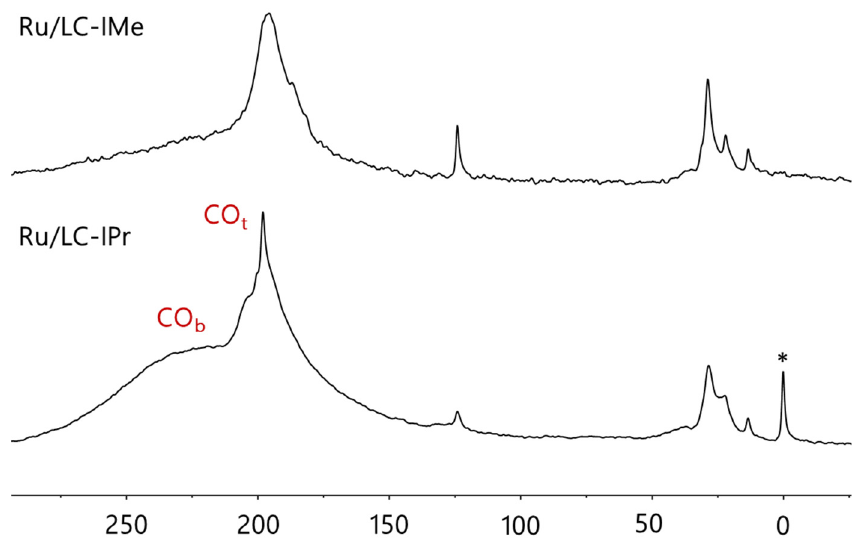
Figure 9. 13 C-MAS NMR spectra of Ru / LC-IMe ( top ) and Ru / LC-IPr ( bottom ) after exposure to 13 CO Figure 9. 13 C ‐ MAS NMR spectra of Ru/LC ‐ IMe (top) and Ru/LC ‐ IPr (bottom) after exposure to 13 CO (1 bar, 20h, r.t.). The peak with asterisk corresponds to grease. Extracted with permission from (1 bar, 20h, r.t.). The peak with asterisk corresponds to grease . Extracted with permission from reference 13. Copyright 2016 The Royal Society of reference 13. Copyright 2016 The Royal Society of Chemistry.